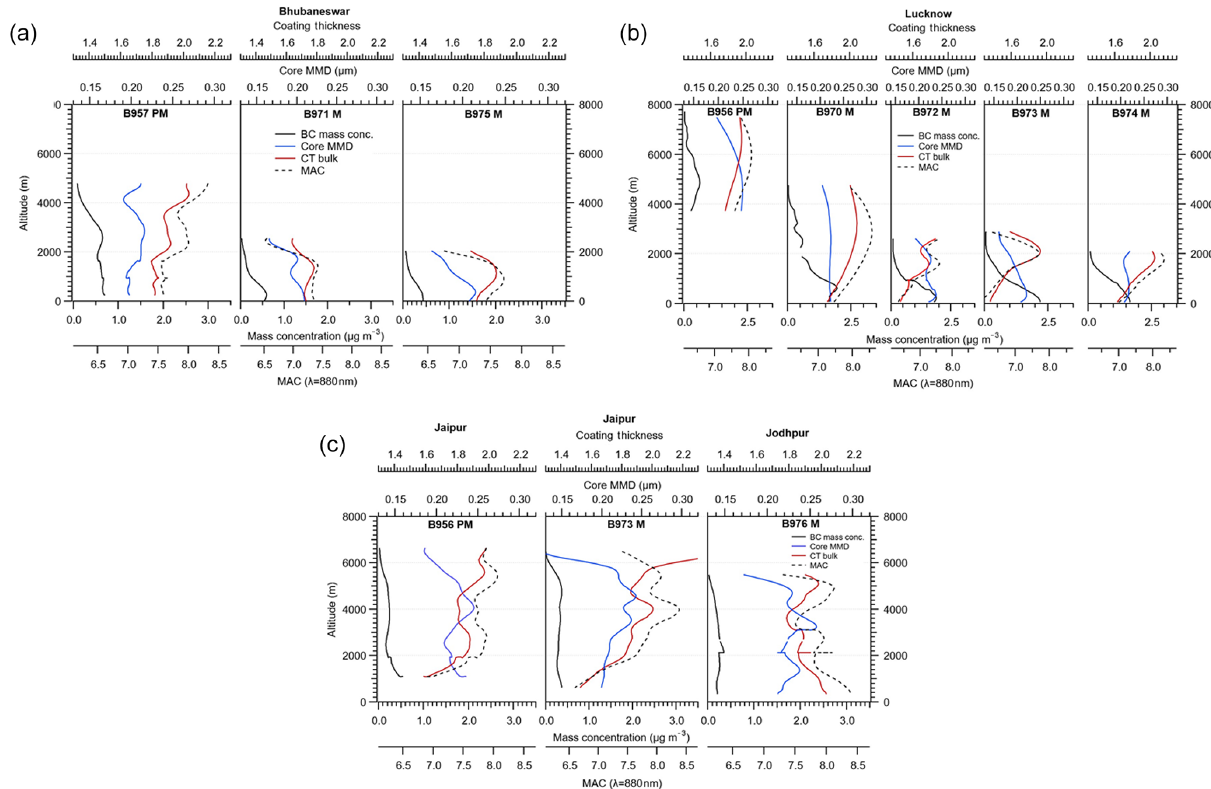
Figure 5. Vertical profile BC physical properties for (a) Jaipur–Jodhpur in NW India, (b) Lucknow in the IGP, and (c) Bhubaneswar in NE India. Data presented are for the pre-monsoon (PM) and monsoon (M)